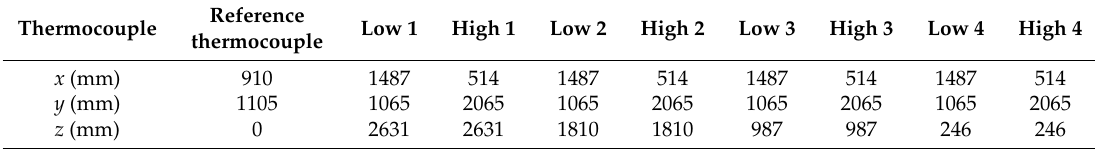
Figure 4. Arrangement of thermocouples in the soaking pit furnace [26]. Table 2. Coordinates of the S-type thermocouples inside the soaking pit furnace.